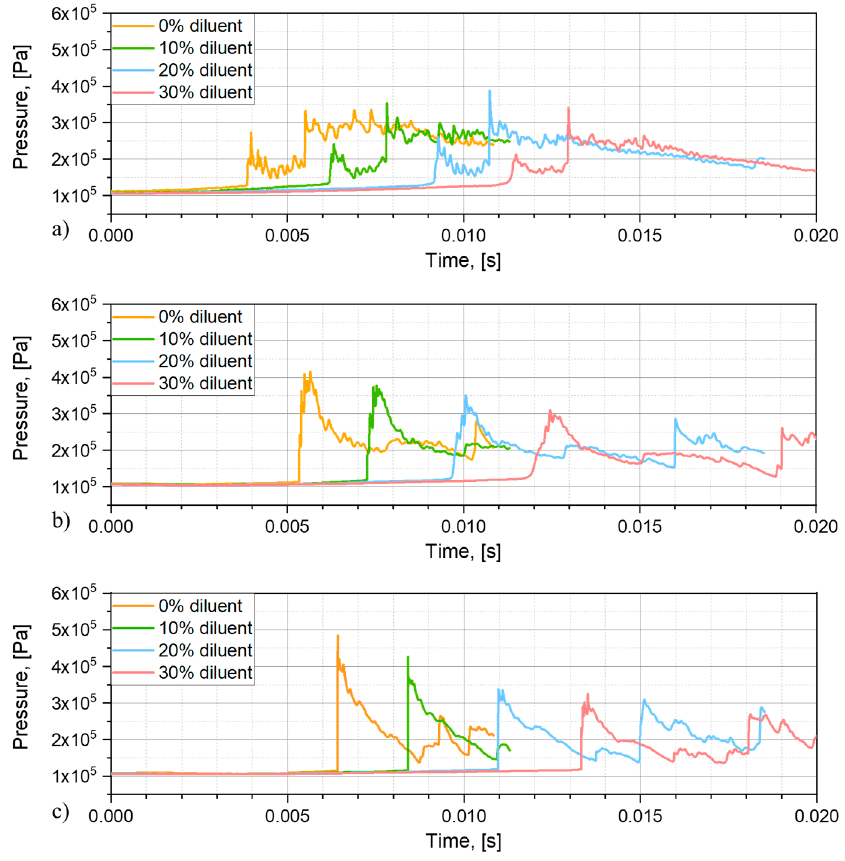
Figure 9. Calculated pressure evolutions at ( a ) 0.665 m, ( b ) 2.277 m, ( c ) 3.015 m.